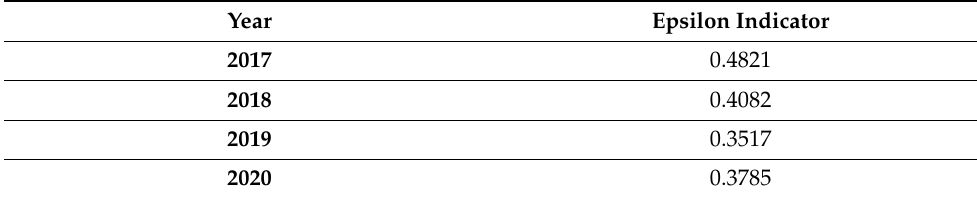
Table 15. Epsilon for EBM every year from 2017 to 2020.